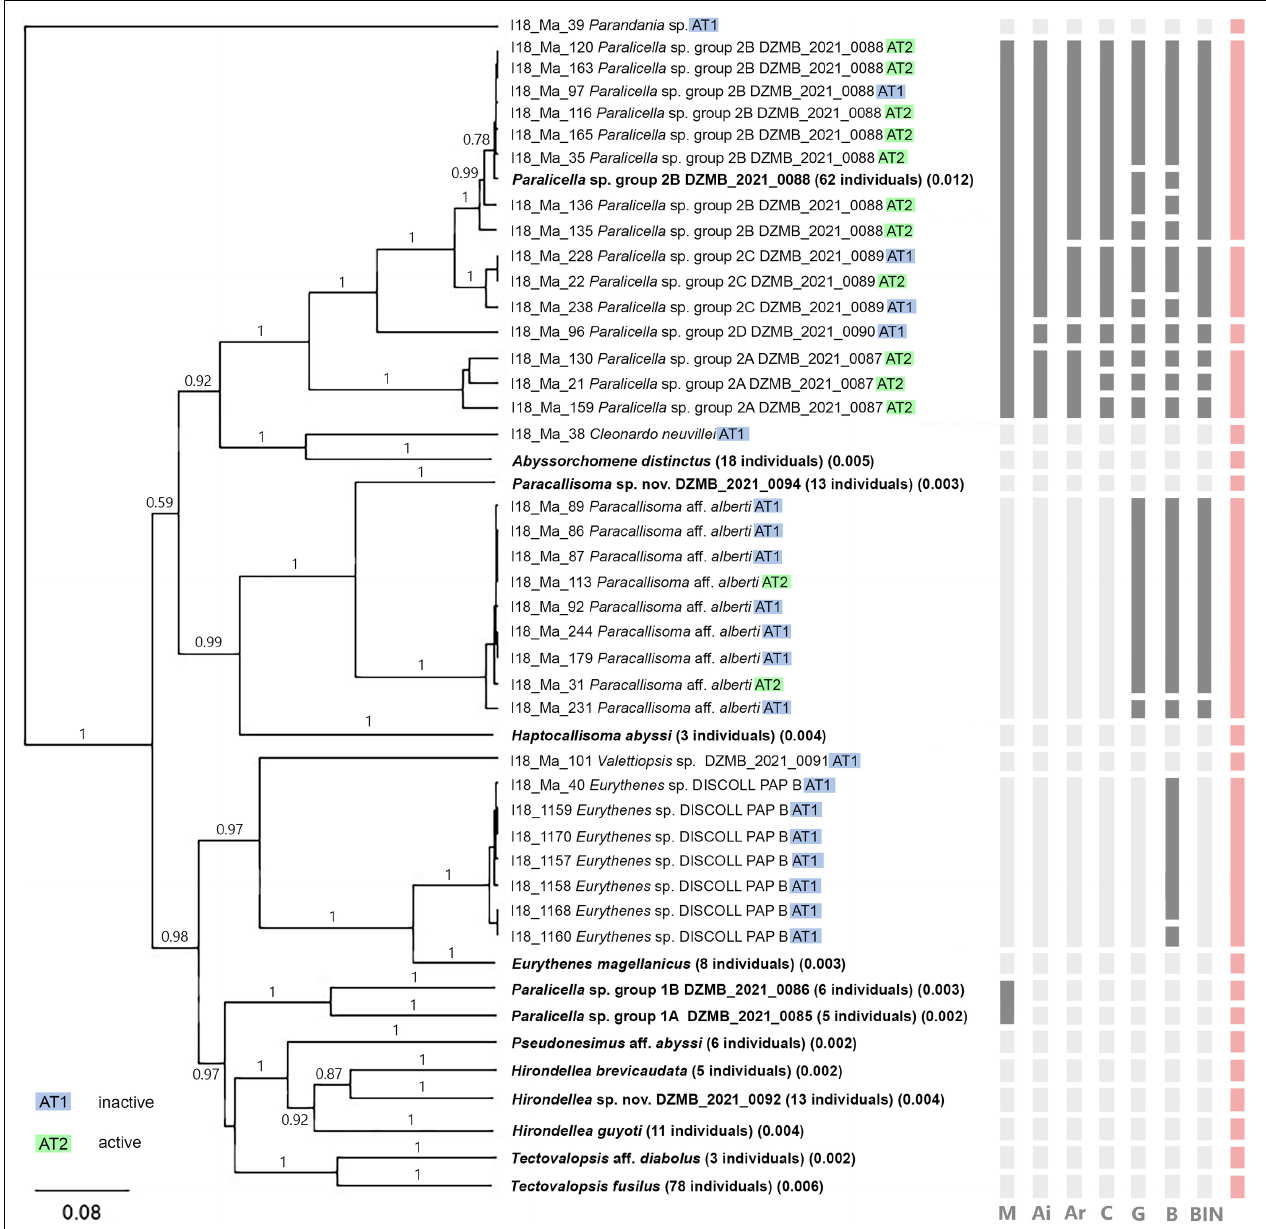
FIGURE 4 | Bayesian inference tree for CO1 data (258 individuals). Tree constructed by using Tamura-Nei substitution and Yule-coalescent model. Numbers represent posterior probabilities (only values higher than 40% are presented). Relevant species delimitation result is shown by vertical bars; disagreements are highlighted: M: morphology. Ai: Automatic Barcode Gap Discovery (initial partition). Ar: Automatic Barcode Gap Discovery (recursive partition). C: CD-Hit. G: general mixed Yule-coalescence GMYC. B: bPTP and BIN. The red bar presents the consensus of all delimitation methods. Samples from AT1 (inactive) and AT2 (active) are color-coded; individuals of one MOTU with matching delimitation results are summarized and highlighted in bold.